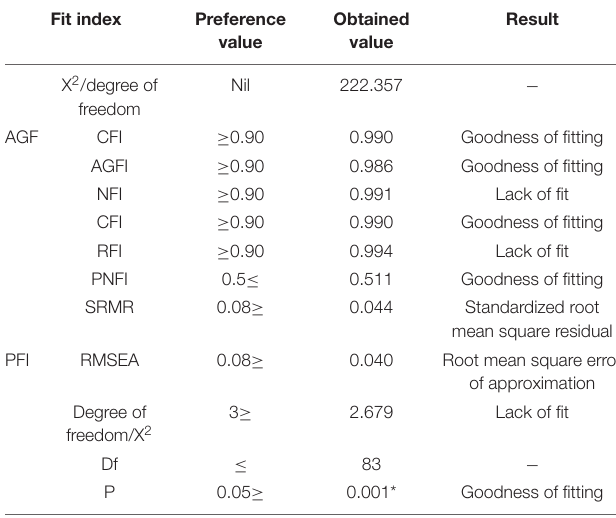
TABLE 7 | Goodness-of-fit indices of the L2WA before